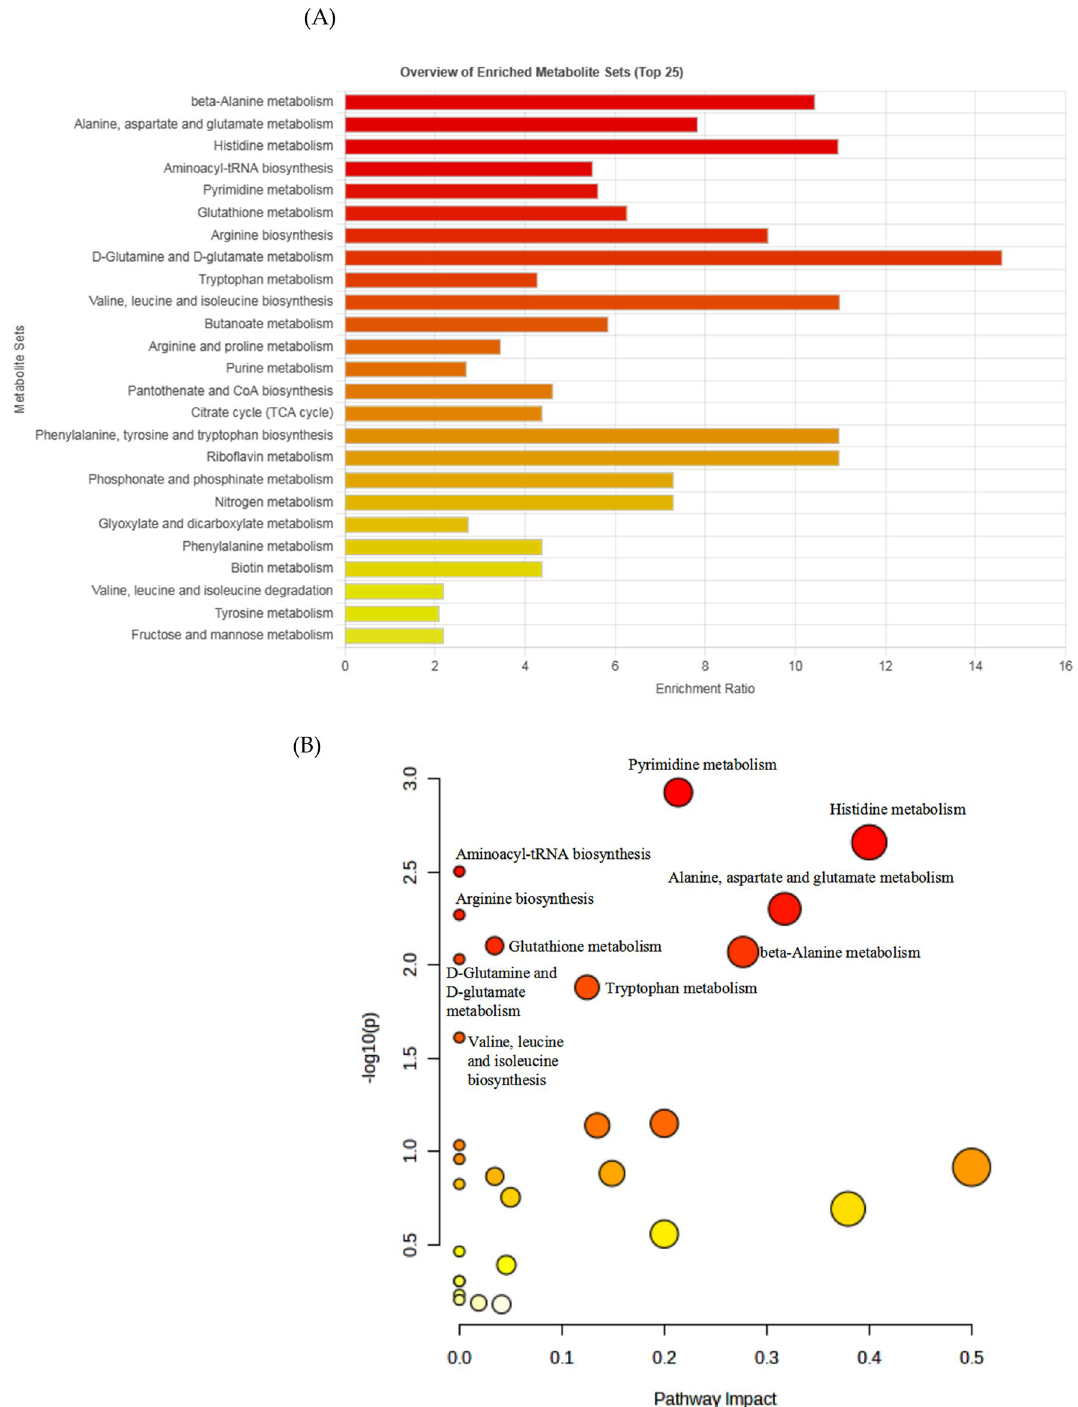
Figure 4. Enrichment of differential metabolites. ( A ) Metabolism pathway enrichment of differential metabolites; ( B ) Pathway impact of differential